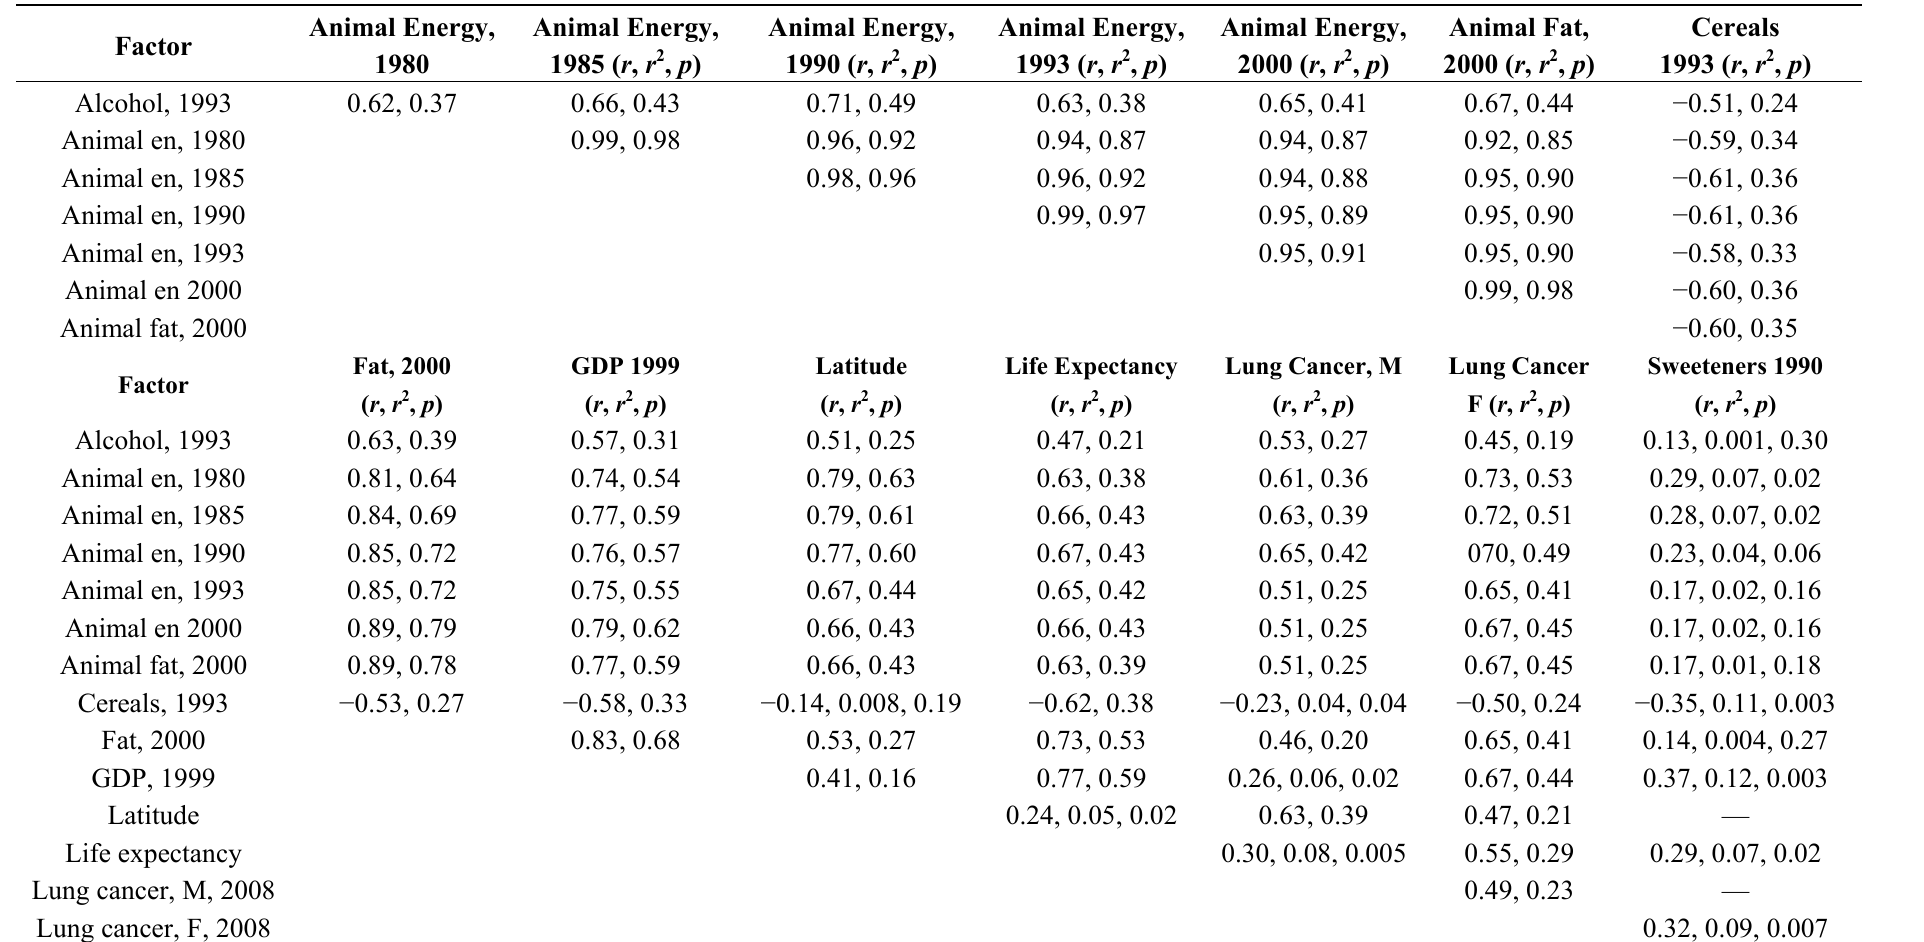
Table 1. Cross-correlations of factors used in this study for the 87 high-quality countries